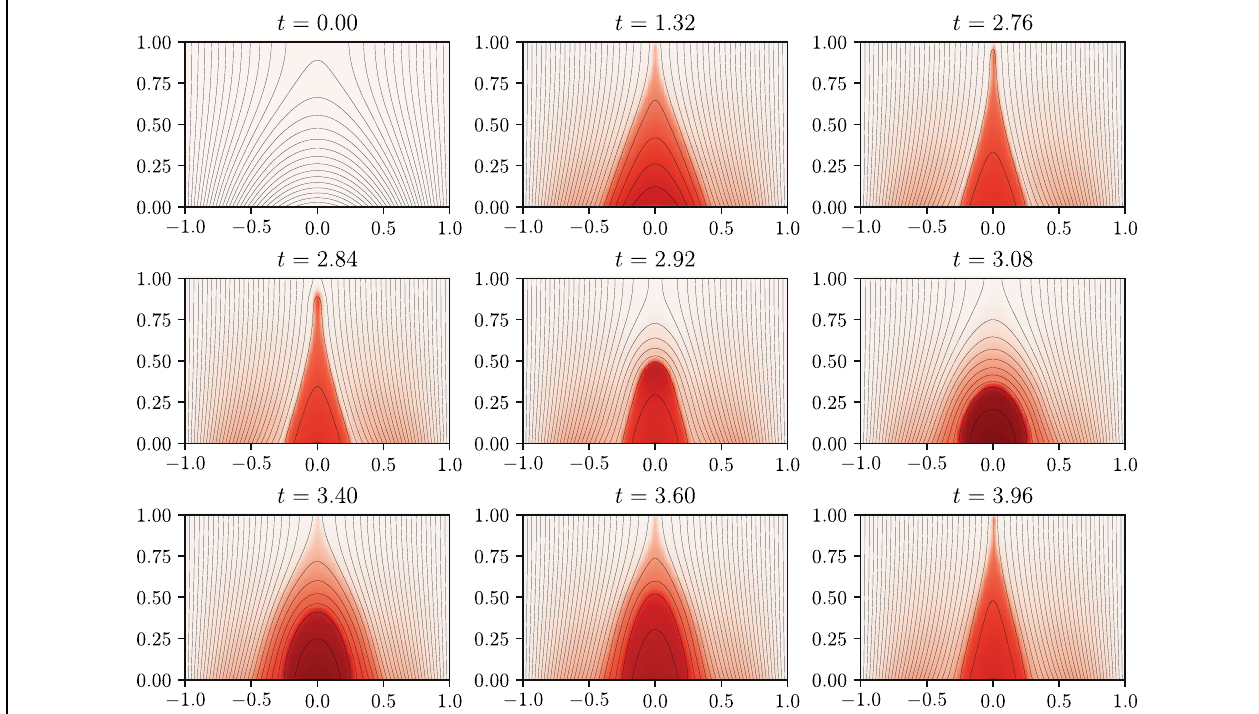
FIGURE 3 | Snapshots showing the shearing of the potential arcade resulting in an arcade eruption and subsequent reformation preceding another eruption at t = 4. The black lines are magnetic field lines projected onto the ( x , z ) plane, and the heatmap represents the magnetic field strength into the page (in the y direction). In this simulation, η 0 = 0 and ν 0 =